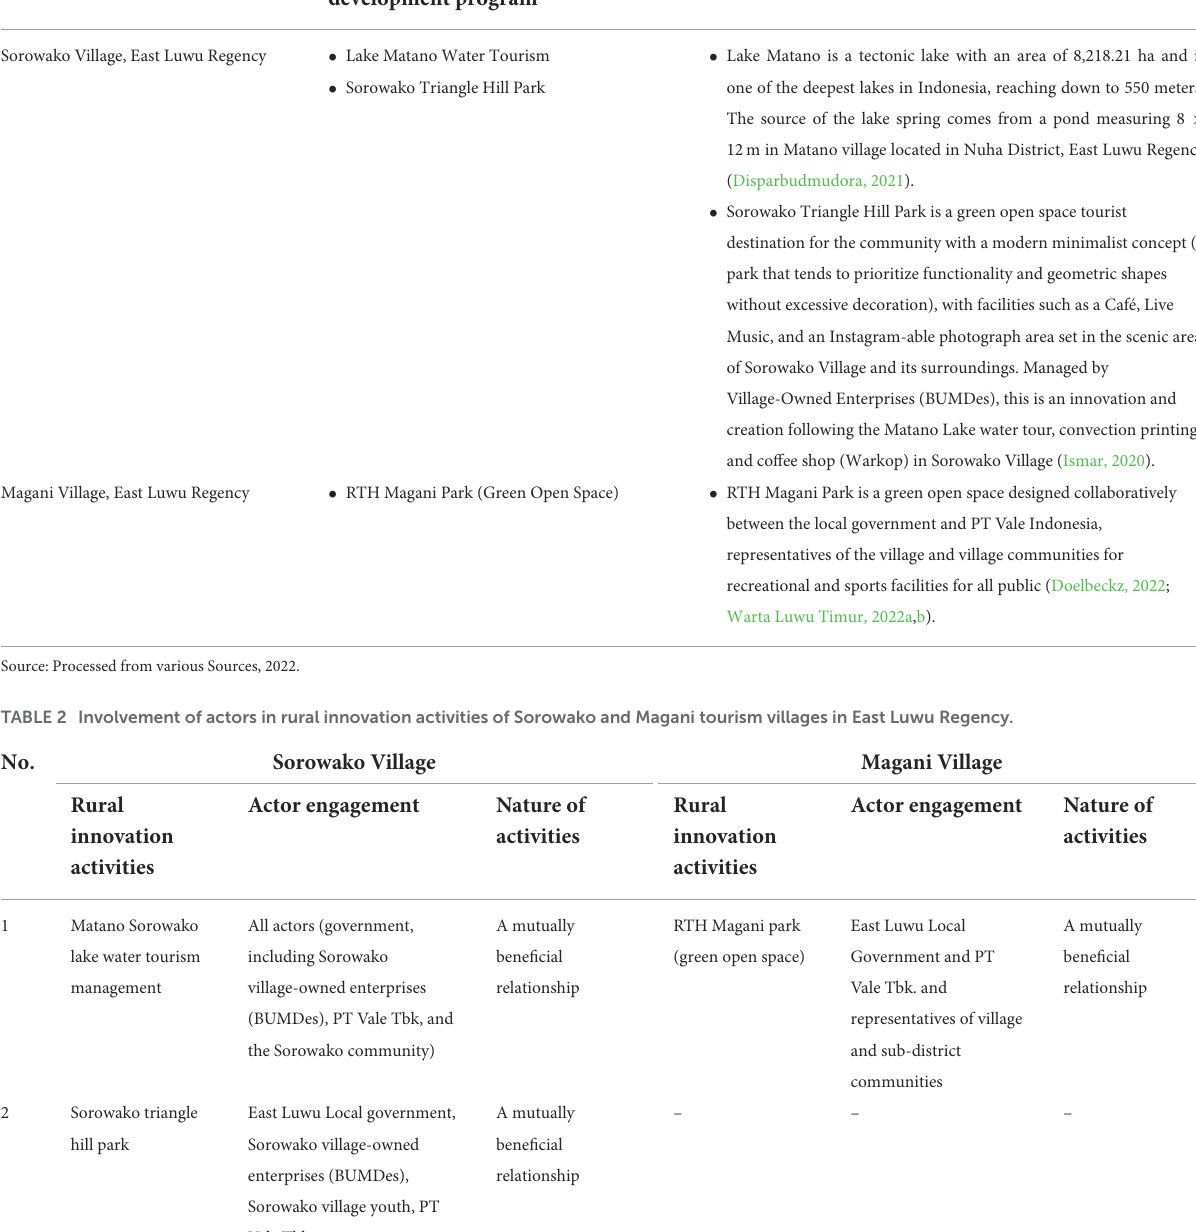
TABLE 1 Collaborative rural innovation program in Sorowako and Magani Villages. Village name